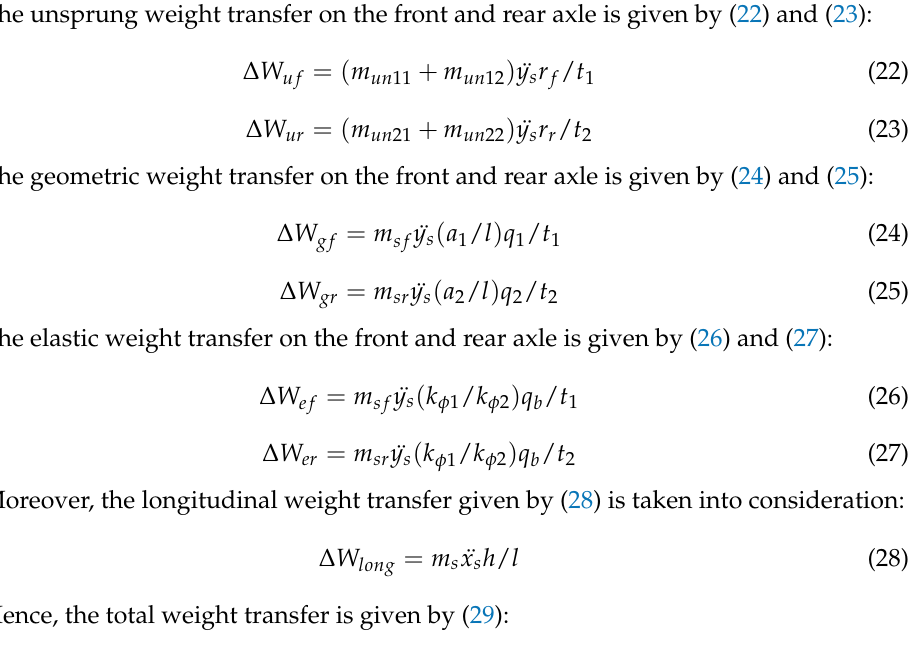
Figure 9. The performance of the vehicle is related to the grip between road and tire. Improving the grip means decreasing the CPLV, which depends on weight transfer and body movements of roll, pitch and